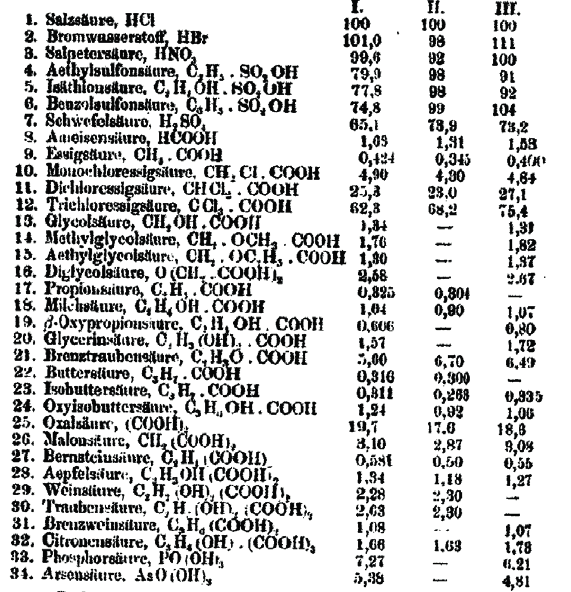
Table 3. Column I. records the conductivities of the acids measured by Ostwald after he received the dissertation Arrhenius has sent to him, column II. the rate constants of the hydrolysis of methyl ace- tate, column III. the rate constants for the inversion of cane sugar. The values were related to HCl =100. Taken from ref. [110]